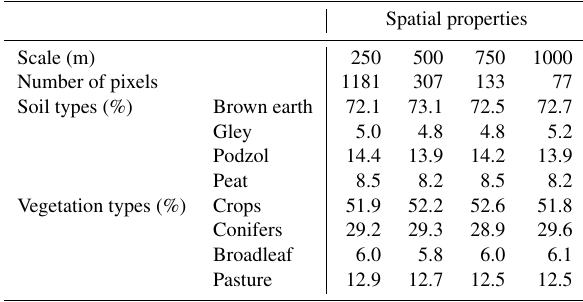
Table 2. Catchment properties with percentages of soil type and vegetation type and the total number of pixels for different grid cell resolutions (at the Demnitzer Millcreek catchment